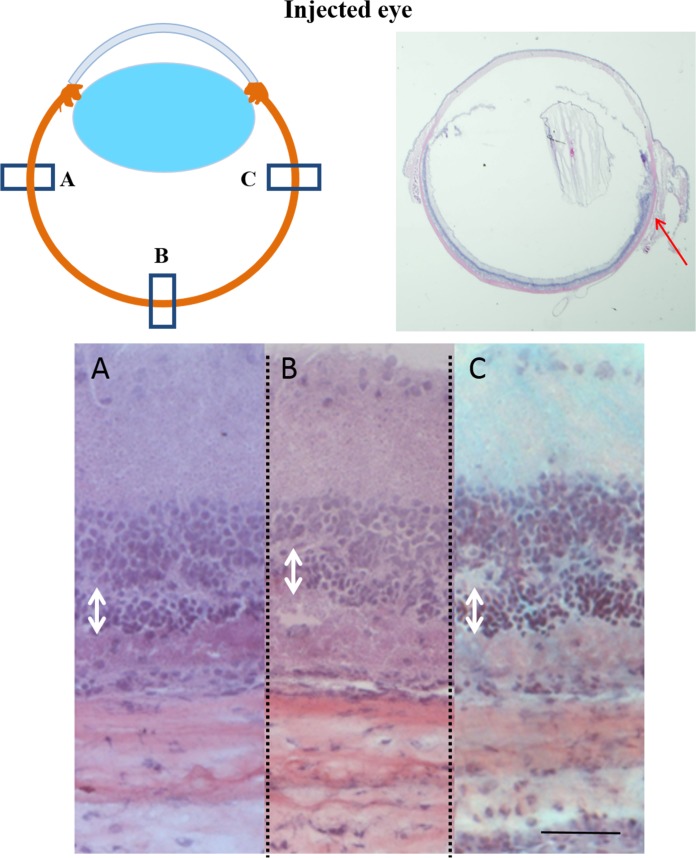
Retinal histology of the injection and non-injection sites at day 70.In eye injected with hWJ-MSCs, there was a generalised preservation of outer nuclear layer (double-headed arrows) over the whole retina as shown at the site of injection (A), middle region (B) and at the site furthest away from the site of injection (C) at day 70. The site of injection was evident by a small remnant subretinal bump (red arrow). This showed that the preservation of outer nuclear layer is not limited to the injection site. Scale bar represents 50 μm.